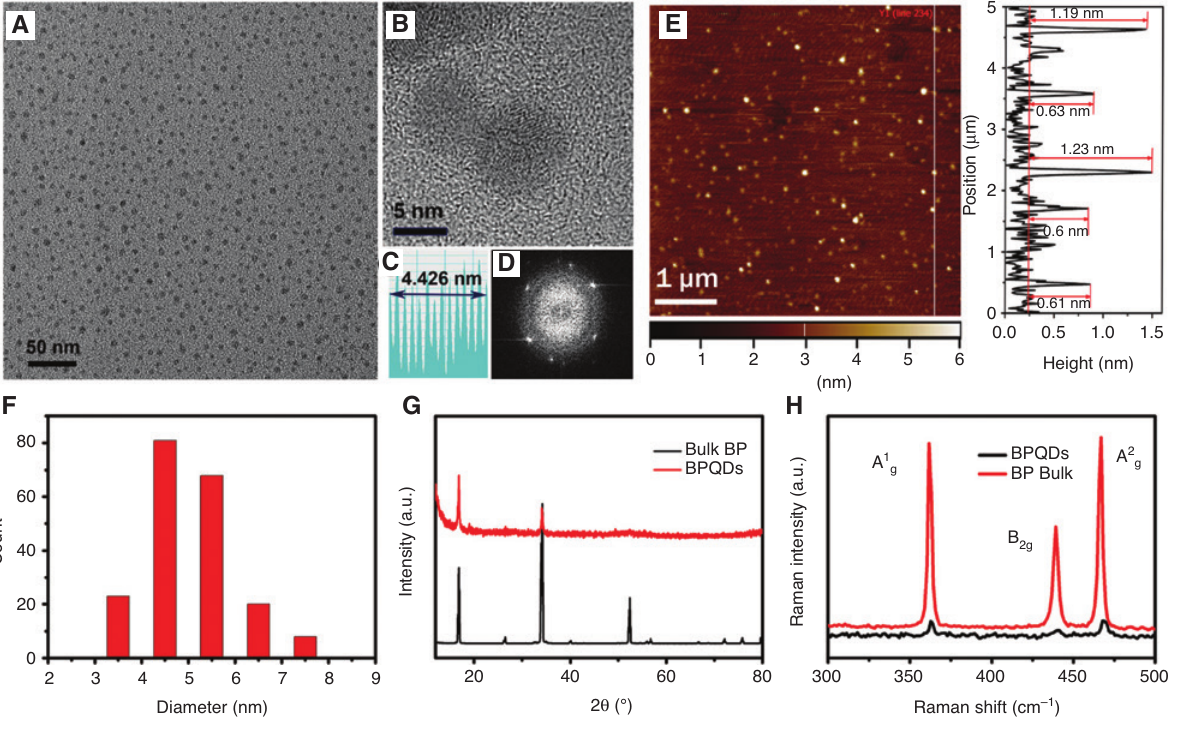
Figure 2: Morphology and characterization. (A) The examination of BPQDs, the HRTEM images of lattice fringes (B and C), and the fast Fourier transform (D) using TEM. (E) The AFM imaging (left). The white line denotes the height profiles (right). (F) The histogram of the sizes of 200 BPQDs measured from the TEM image. (G) The X-ray diffraction pattern of bulk BP and BPQDs. (H) The Raman spectra of BPQDs and the bulk